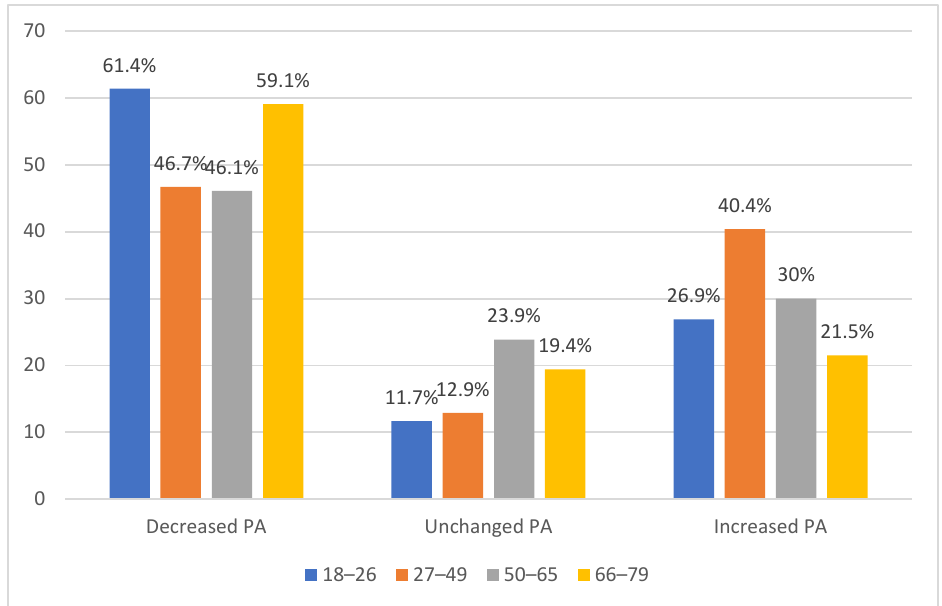
Figure 2. Proportion, dichotomized into age groups, of participants reporting decreased, increased, or unchanged total PA. Note: A significant difference existed between the age groups, χ 2 (6) = 70.772 ( p < 0.001).